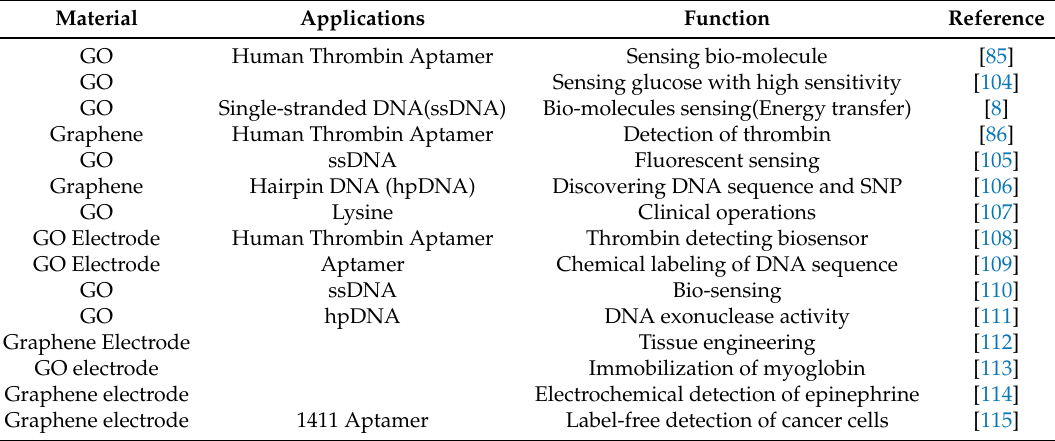
Table 2. Application area of